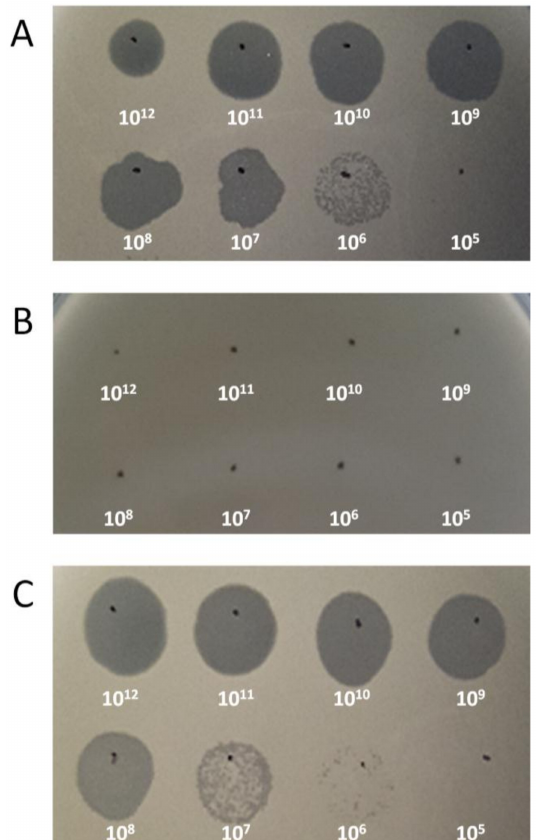
Figure 2. Wall teichoic acid (WTA)-dependent infection of S. aureus phage CSA13. ( A ) Phage CSA13 lysate was spotted onto lawns of wild-type RN4220, ( B ) ∆ tagO mutant, and ( C ) tagO -complemented strains. Each number indicates the titer (PFU/mL) of phage CSA13 spotted on the plate. Plaque formation indicates successful adsorption and infection by phage